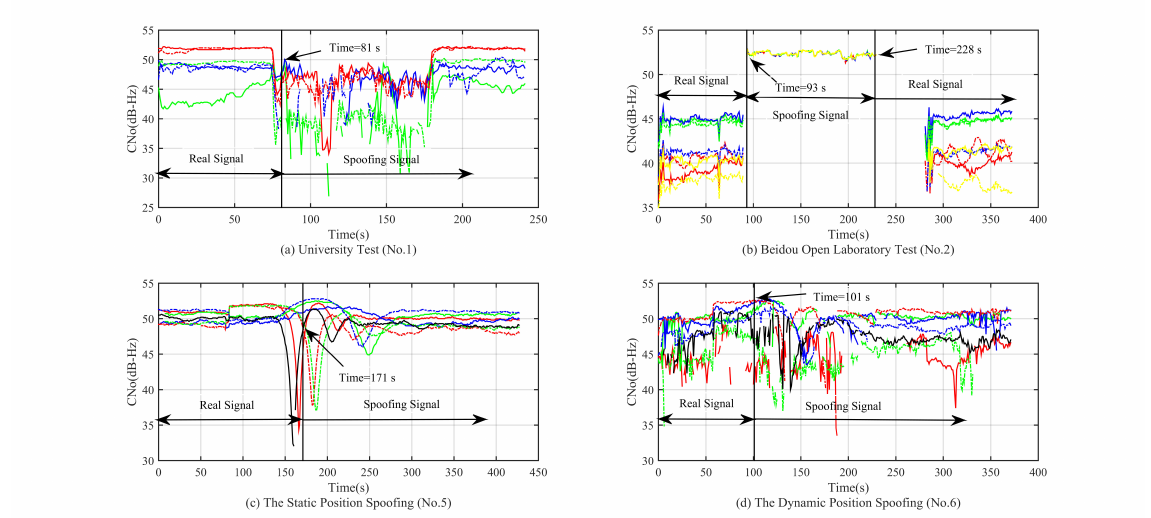
Figure 14. Curve of the carrier noise power ratio (C/No) in different experimental